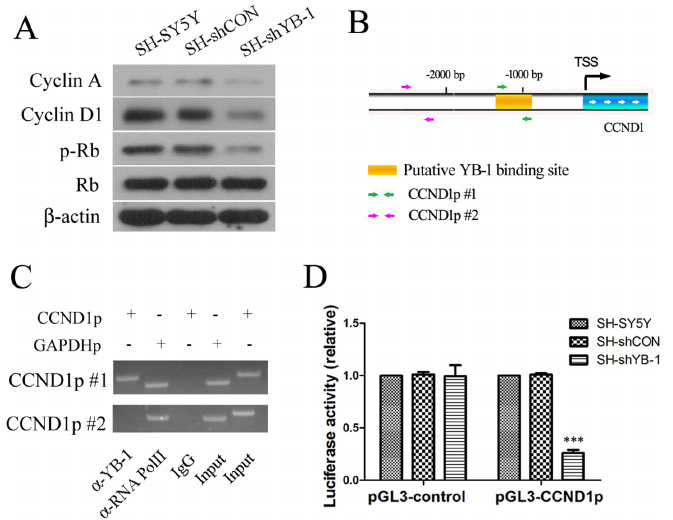
Fig 3. YB-1 regulated Cyclin D1 transcription in neuroblastoma SH-SY5Y cells. (A) Expression levels of cell cycle regulators such as Cyclin A and Cyclin D1 in SH-SY5Y, SH-shCON and SH-shYB-1 cells were examined by Western blot analysis. (B) A schematic illustration of the promoter region of CCND1 which encodes Cyclin D1 indicates the transcription start site (TSS), putative YB-1 binding site and the location of two sets of primers (CCND1p #1 and #2) used for chromatin-immunoprecipitation (ChIP) assay. (C) ChIP assay followed by PCR analysis was performed in SH-SY5Y cells to detect binding of YB-1 on the promoter region of CCND1. Binding of RNA polymerase II (RNA PolII) on GAPDH promoter, which was detected with primers for GAPDH promoter (GAPDHp) by PCR, was used as a positive control for ChIP experiments, whereas IgG served as a negative control for non-specific binding. (D) pGL-3 Firefly luciferase reporter plasmid containing a CCND1 promoter fragment (pGL-3-CCND1) or pGL-3 vector alone was transfected in combination with Renilla luciferase reporter vector pRL-TK into SH-SY5Y, SH-shCON and SH-shYB-1 cells. Luciferase activity representing activity of the promoter was quantified as the ratio of FL/RL which was then normalized to SH-SY5Y cells. Values are expressed as mean ± standard deviation. Compared with SH-SY5Y control, *** P <